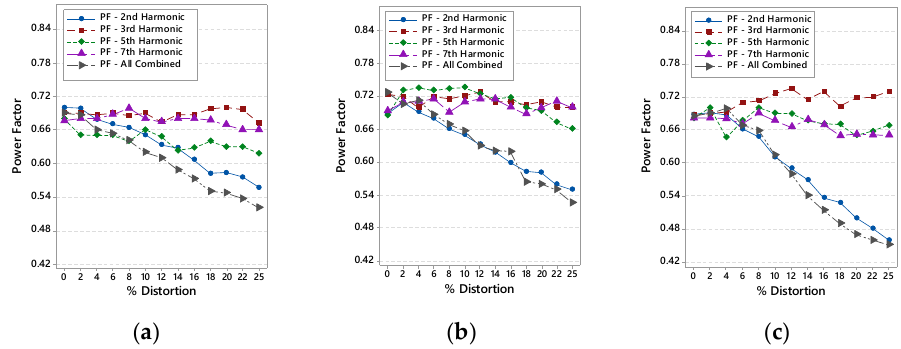
Figure 10. Power factor decrease for 2nd, 3rd, 5th, 7th and all harmonic order combined for induction motors ( a ) IE2 SCIM; ( b ) IE3 SCIM; ( c ) IE4 LSPMM.